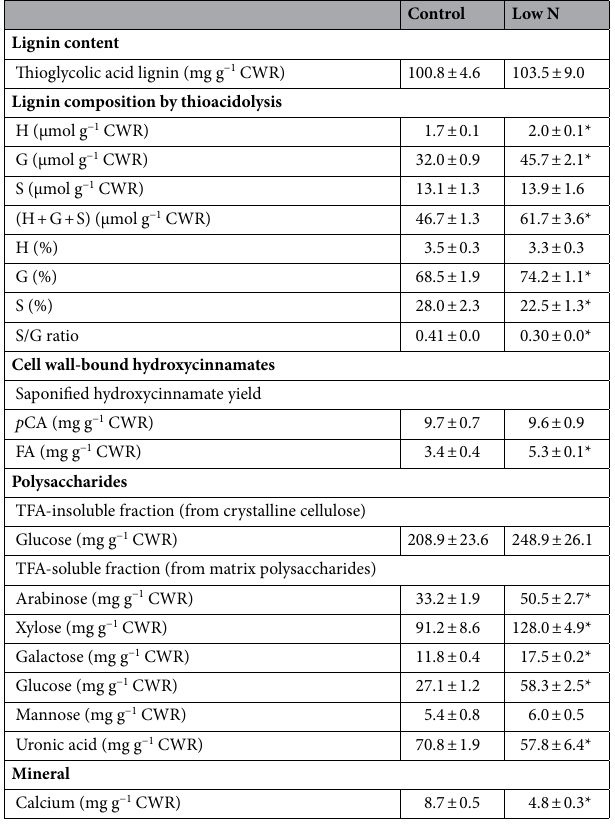
of cell wall polysaccharides, by quantifying uronic acids, and calcium (Ca) possibly bound to pectin. The uronic acid and Ca contents were decreased by 18% and 45% in low-N plants, respectively (Table 1). Methylation analysis revealed the presence of at least 16 glycosyl residues with different linkages in the cell walls of sorghum seedlings (Table 2). Of the sugar residues listed in Table 1, mannose, which was probably derived from mannans, remained unaffected by the low-N treatment. Therefore, we estimated the amount of each detected residue relative to 4-linked mannosyl. The glycosyl residues that were increased by low-N treatment included 3- or 4-linked glucosyl and 4- or 3,4-linked xylosyl residues (Table 2). In grass cell walls, the 3-linked glucosyl residue is found in callose [(1 → 3)-β-d-glucan] and MLG, whereas the 4-linked glucosyl residue in non-crystalline (1 → 4)-β-d-glucan and MLG. The 4- and 3,4-linked xylosyl residues are found in xylans with were found to be increased in the composition analysis (Table 1) but not in the methylation analysis (Table 2) of the glycosyl residue. The reason for this apparent discrepancy is unclear at present. Nuclear magnetic resonance analysis. To further investigate the low N-induced alterations of the sor- ghum cell wall structure, we performed 2D HSQC NMR analysis on the cell wall samples from the sorghum seedlings using the NMR approach 43,44 . The aromatic sub-regions of the obtained HSQC NMR spectra displayed well-resolved contour signals from the lignin aromatic units such as S ( S ), G ( G ), and tricin ( T ) units, along with the signals from the hydroxycinnamate FA ( F ) and p CA ( P ) units (Fig. 2a). In addition, the sugar anomeric sub-regions of the spectra displayed contour signals from cell wall polysaccharide components, including glucan ( Gl ), non-acetylated ( Xy ), and acetylated ( Xy ʹ and Xy ʹʹ ) xylan, arabinan ( Ar ), galactan ( Ga ), and glucuronan ( GU ) units (Fig. 2b). To estimate the structural differences between the control and low-N sorghum cell walls, these contour signals were integrated and normalized based on the sum of the S and G lignin aromatic signals ( S + G ) (Fig. 2c,d). The S ( S ) and G ( G ) lignin signals were relatively decreased and increased, respectively, in the HSQC spec- trum of the low-N sorghum cell walls compared to those in the HSQC spectra of the control cell walls (Fig. 2c). Consequently, the S / G signal ratio was notably reduced in the low-N cell wall spectrum (0.13) compared to that